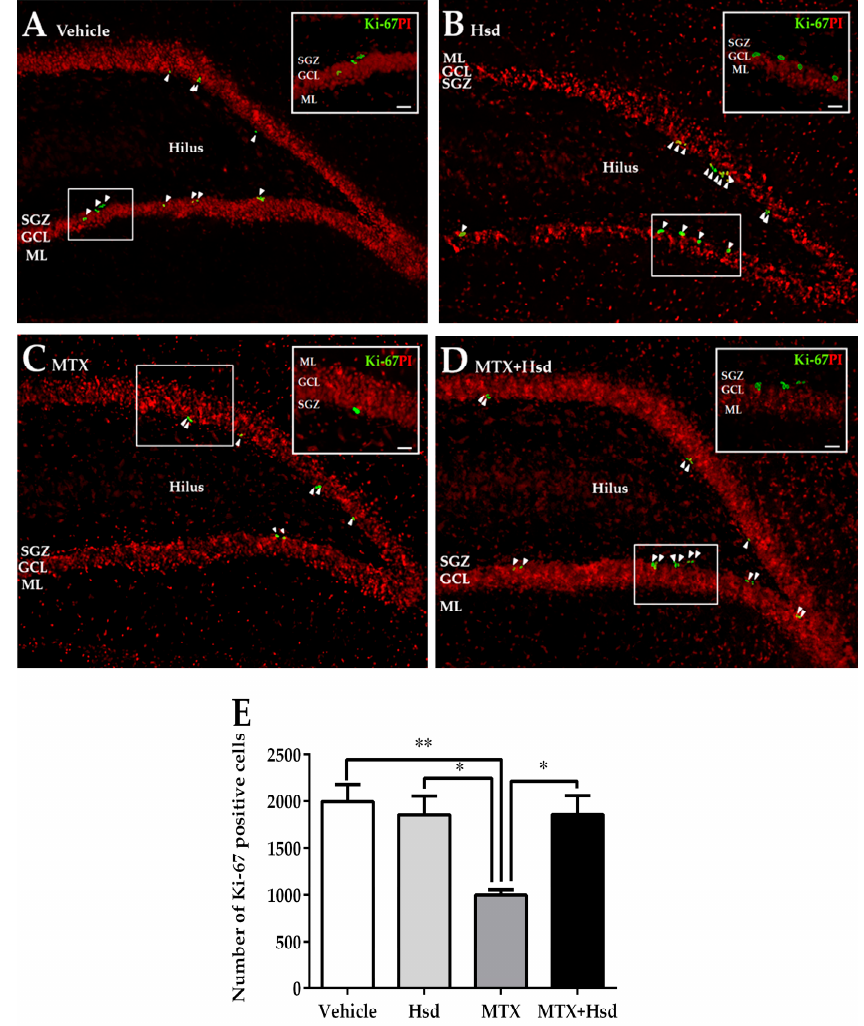
Figure 5. Cells stained with Ki-67 (green) in the SGZ of the DG in the hippocampus in the vehicle group ( A ), Hsd group ( B ), MTX group ( C ), and MTX + Hsd group ( D ). The results are represented as mean ± SEM. The vehicle, Hsd, and MTX + Hsd groups showed significantly higher cells stained with Ki-67 than the MTX group (Data are displayed as mean ± S.E.M., * p < 0.05; ** p < 0.01 significantly different from the MTX group) ( E ). SGZ: subgranular zone; GCL: granule cell layer; ML: molecular layer.